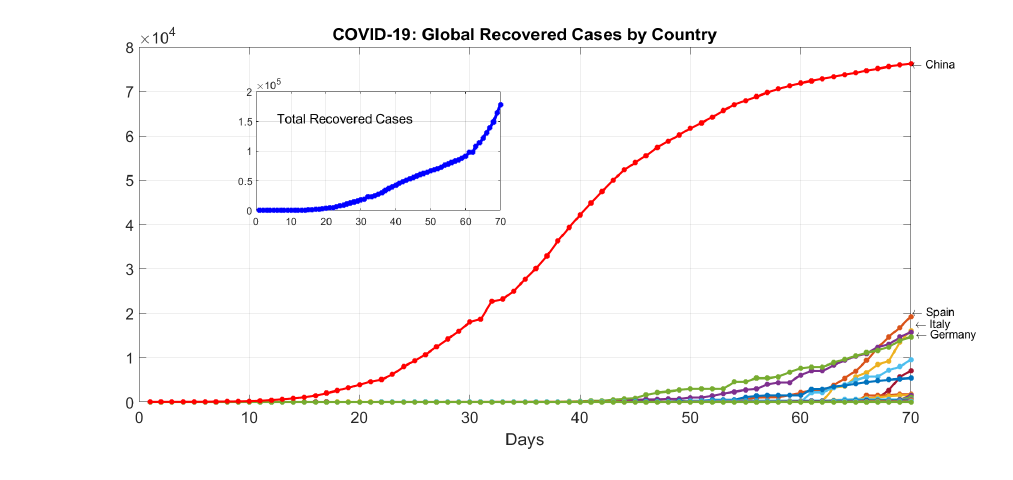
Figure 6. Time series of global recovered cases of COVID-19 from 22 January to 31 March.